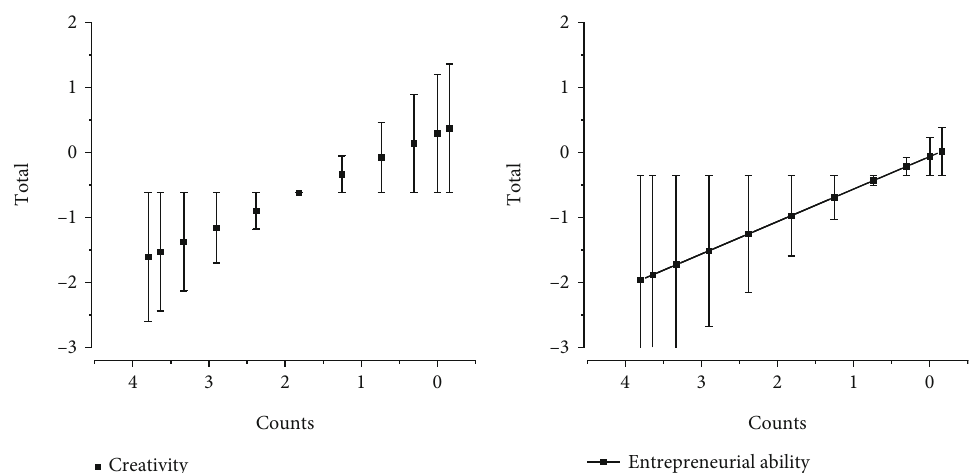
Figure 1: One-way ANOVA of innovation and entrepreneurship in di ff erent levels of participation in theoretical courses.